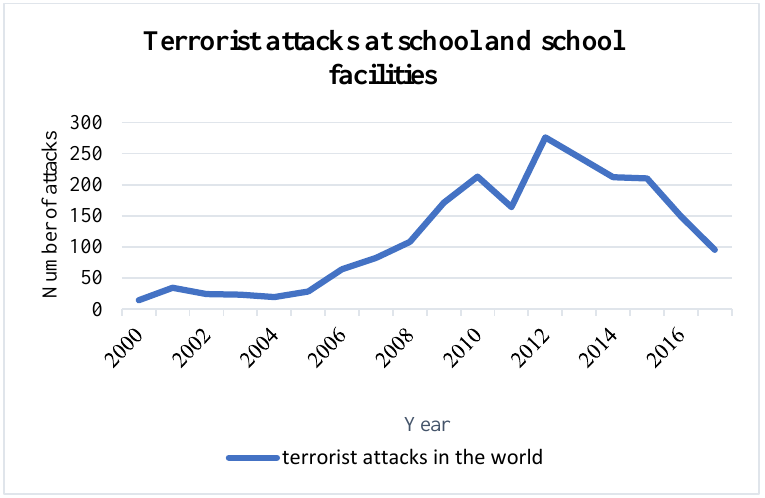
Figure 2. The evolution of terrorist attacks at schools and school facilities in 2000 – 2017 [20].